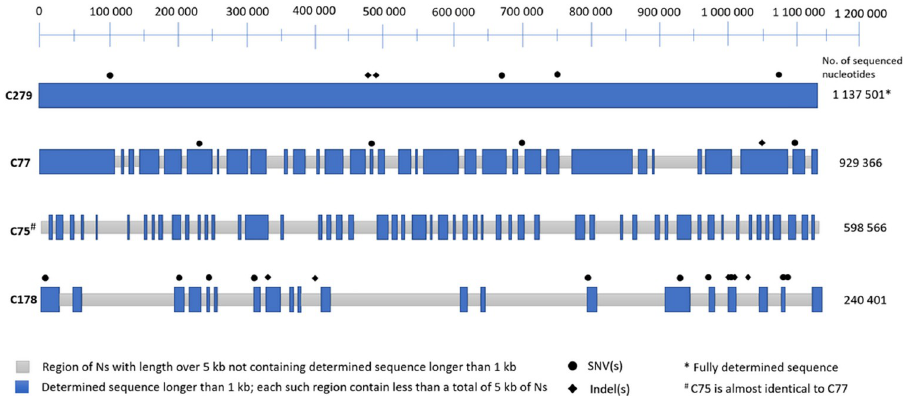
Fig 1. Comparison of breadth coverage of individual genomes. Sequenced genomic region of Cuban isolates with marked total sequenced genome length. Gray represents regions of Ns with length at least 5 kb, which were not interrupted with more than 1 kb of sequenced nucleotides. Regions containing SNVs and indels in Cuban bejel genomes are shown as symbols (•, ♦